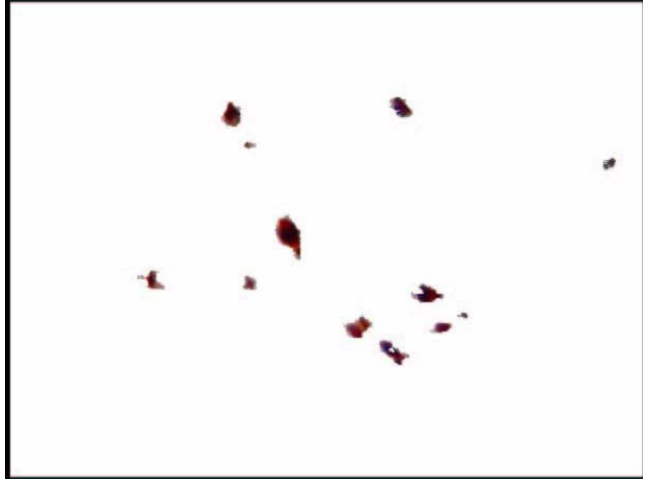
Fig. 6 Segmented Ki67 after orthogonal projection of its spatial